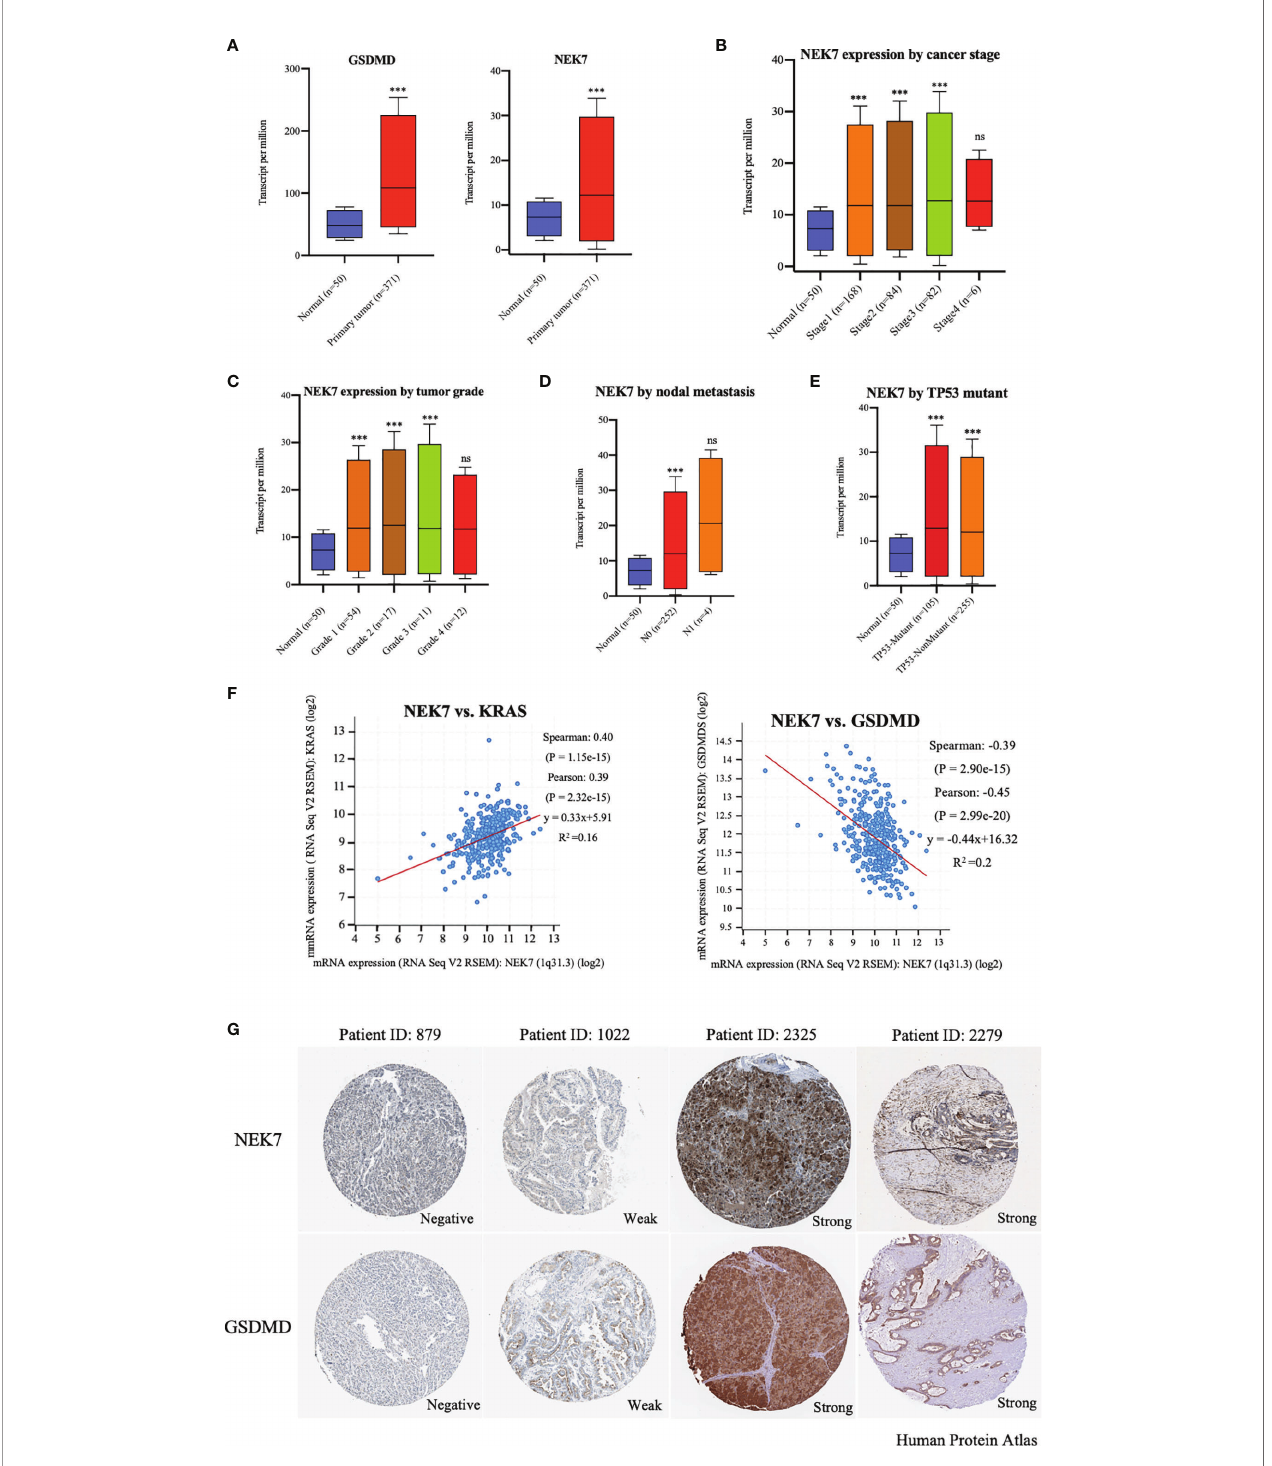
FIGURE 1 | Expression of NEK7 correlated with GSDMD in hepatocellular carcinoma in bioinformatics analysis. (A) Expressions of NEK7 and GSDMD were signi fi cantly upregulated in tumor tissues compared to tumor-adjacent normal tissues. *** p < 0.001. (B – E) Expression of NEK7 signi fi cantly correlated with liver hepatocellular carcinoma cancer stage, tumor grade, nodal metastasis, and TP53 mutant. *** p < 0.001. ns, no signi fi cance. (F) Expression of NEK7 signi fi cantly correlated with Kras and GSDMD in HCC tissues. (G) Heterogenetic expressions of NEK7 and GSDMD in HCC tissues. NEK7 and GSDMD were co-expressed in the same tumor